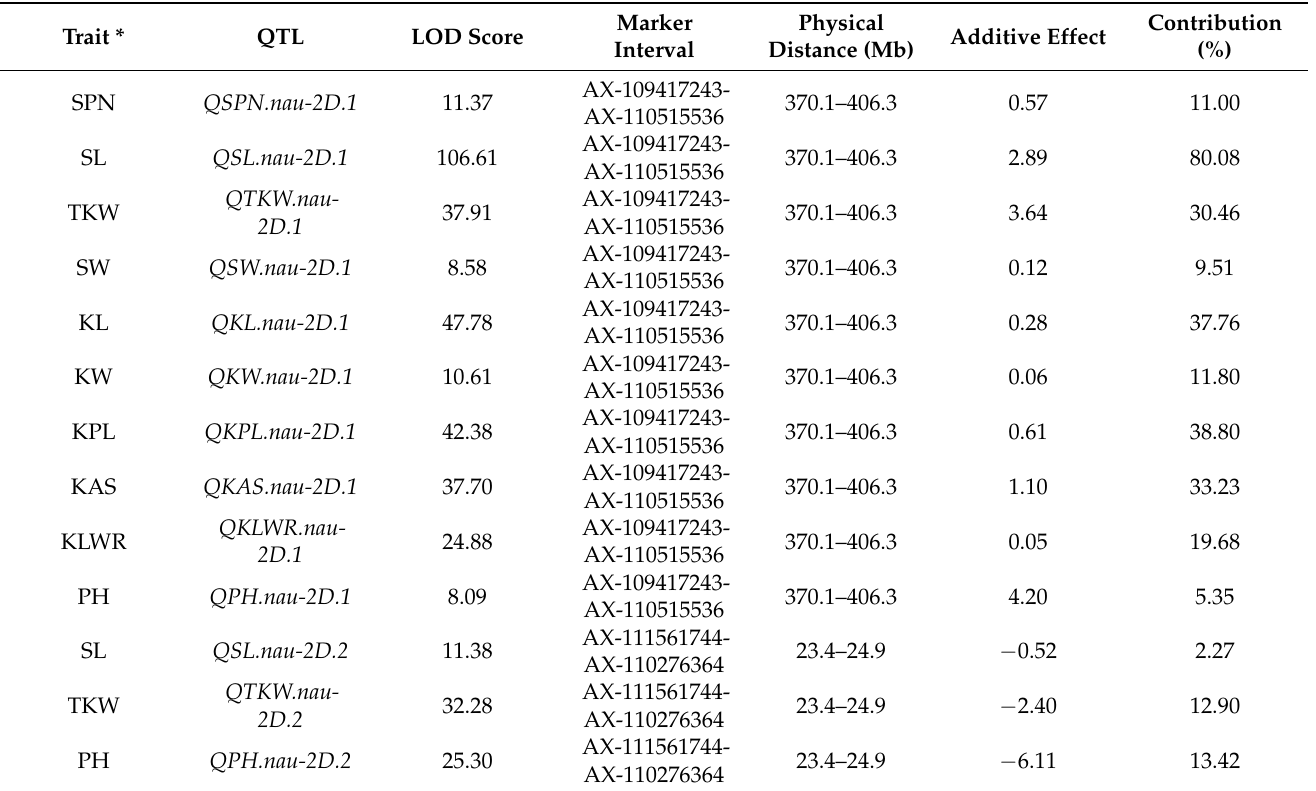
Table 3. Summary of QTL for PH and grain and spike-related traits mapped to the same regions with QSD.nau-2D.1 and QSD.nau-2D.2 on chromosome 2D in the RIL population using BLUP values from four environments